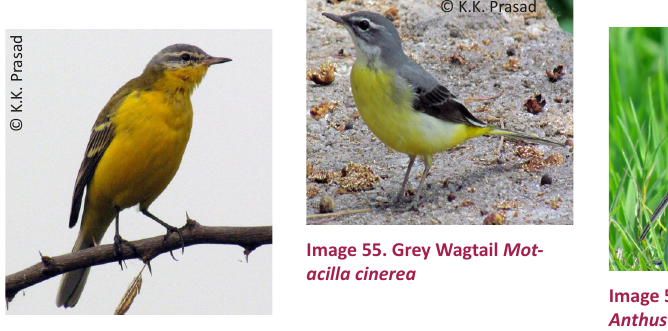
Image 56. Paddyfield Pipit Anthus rufulus